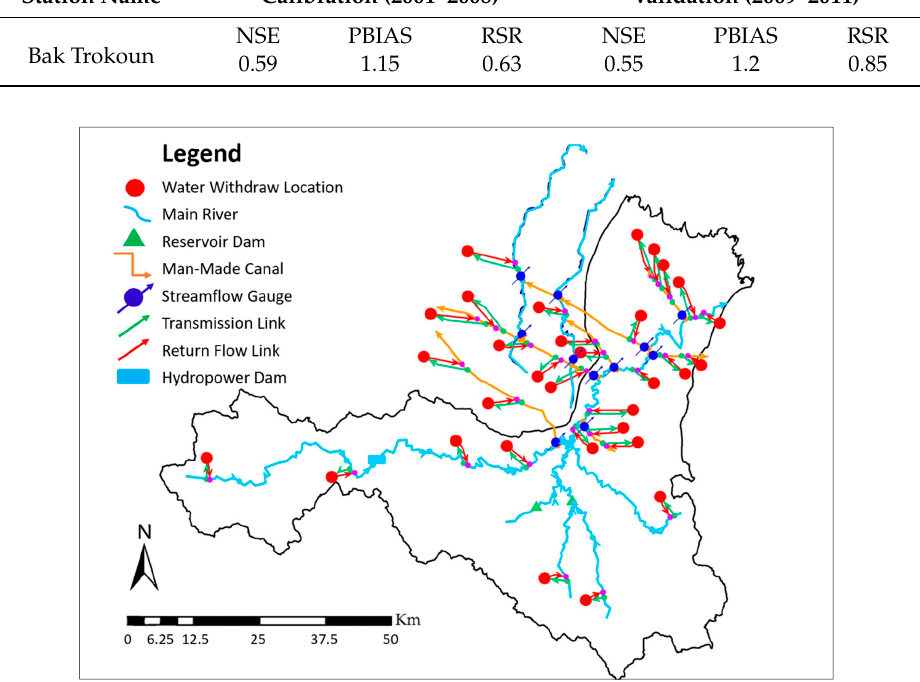
Figure 4. The schematic view of the Pursat River Basin (PRB) on WEAP model interface illustrated the hydrologic and infrastructural connections after adding three reservoirs. A physical component such as a water withdrawal point, or main water-use location along a river system are viewed by rounded red notes. Each node is linked by lines that represent the natural or artificial water networks such as river channels and man-made canals. These lines consist of rivers, water diversion, transmission links, and return flow links. A river reach is defined as the section of a river or diversion between two river nodes. Elements in the schematic of the PRB: River, Diversion, Streamflow Gauge, Agricultural Demand Site, Domestic Demand Site in Pursat urban; Domestic Demand Site in Pursat suburbs and rural; Industrial Demand Sites; added reservoirs: Dam 1, Dam 2 and Dam 3.